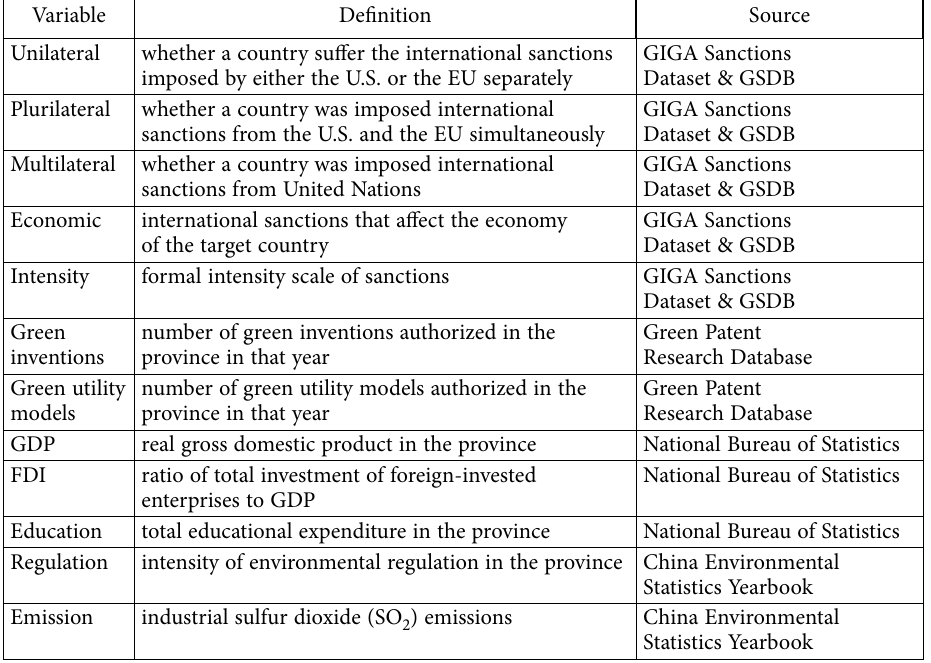
Table A1. Definitions of variables and data sources